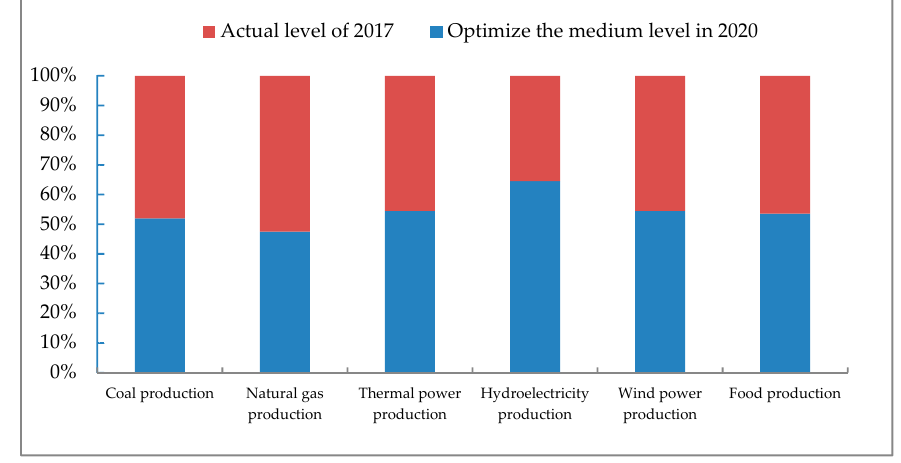
Figure 3. Production comparison chart between horizontal year and planned year.